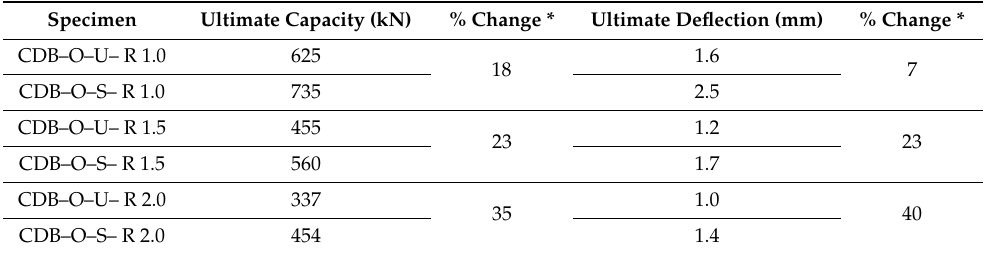
Table 7. Ultimate capacities and mid-span deflections of RCCDBs with different ratios of the open- ing dimensions.